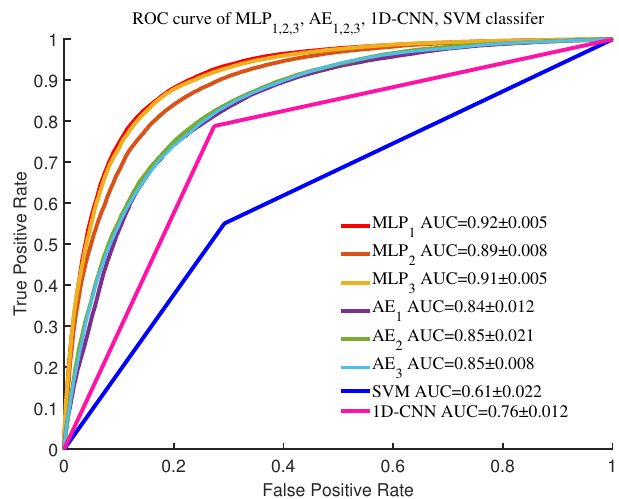
Figure 10. ROC curves of the proposed MLP, AE, 1D-CNN, SVM classifiers. Note that the MLP 1 achieved the highest AUC = 0.92 ± 0.005.